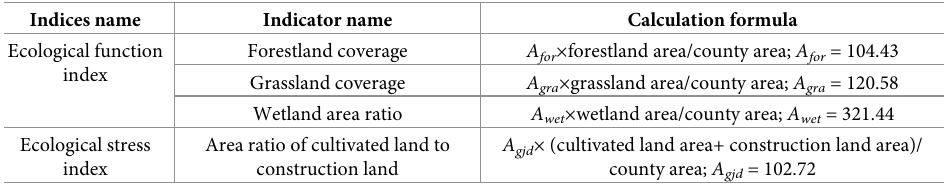
Table 2. Calculation formula of ecological structure index and ecological stress